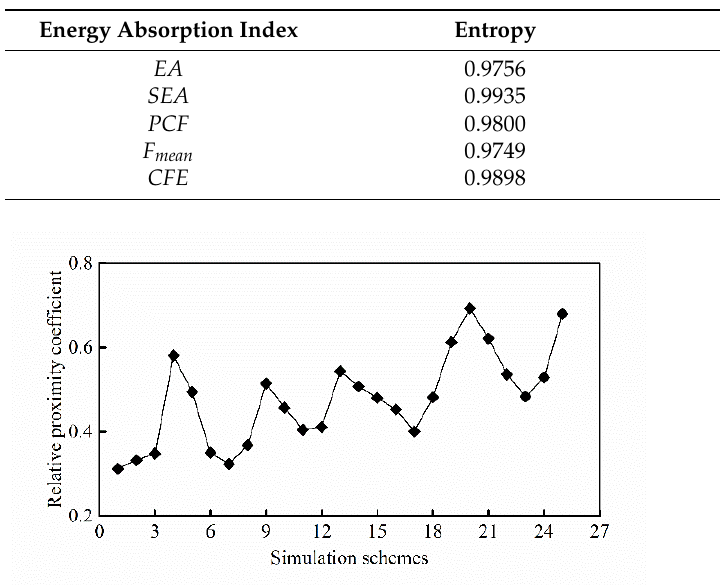
Figure 12. Relative proximity coefficient for each simulation scheme.